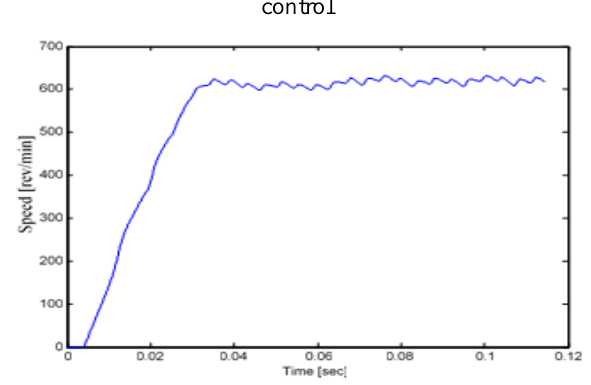
Fig. 12. Speed waveform of 4-phase machine excluding the control